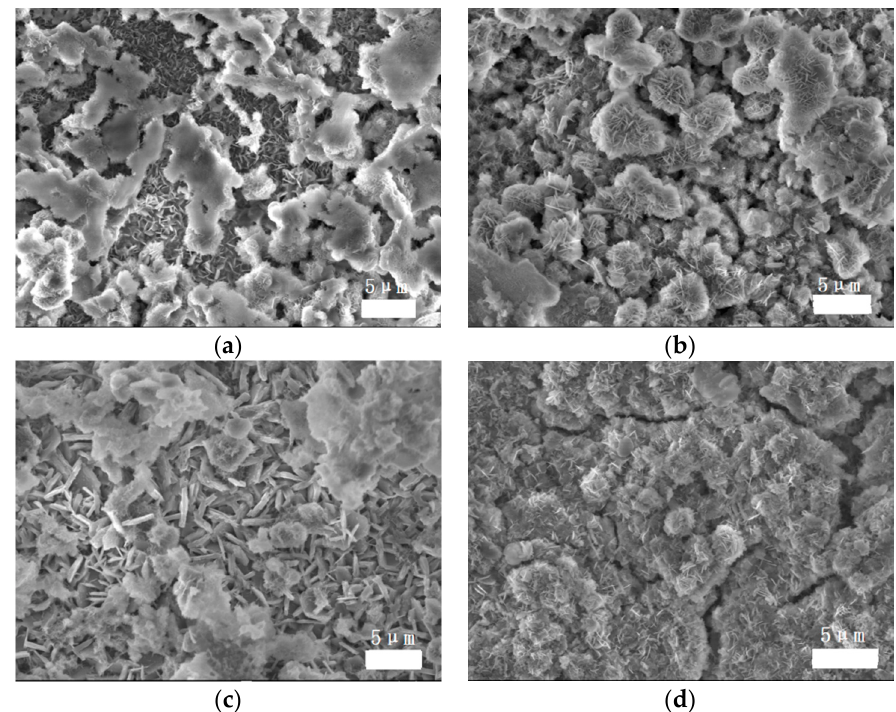
Figure 5. The surface of the coating is magnified 3000× in different corrosion times: ( a ) 24 h; ( b ) 48 h; ( c ) 72 h; and ( d ) 96 h.